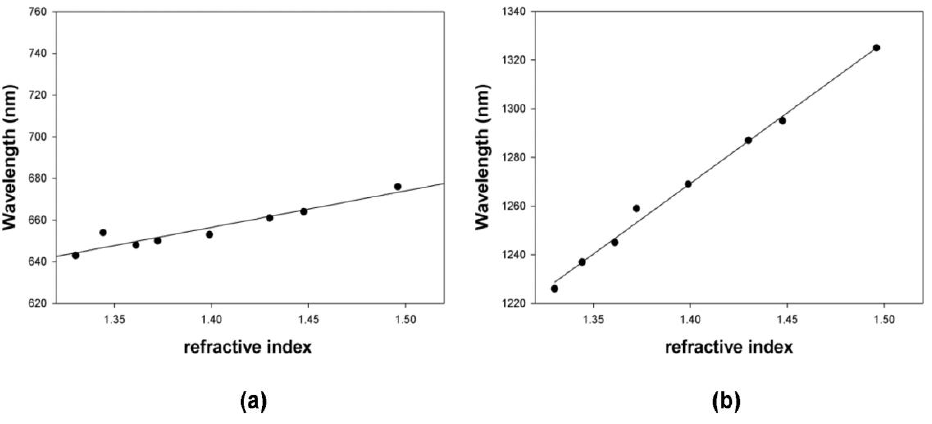
Figure 8. Plasmon resonance wavelength as a function of the refractive index (a: LSPR 2, b: LSPR 3), when the gold nanostars are suspended in different solvents: water (n = 1.3300); acetonitrile (n = 1.3442); ethanol (n = 1.3611); ethyl acetate (n = 1.3723); n -butanol (n = 1.3990); N,N-dimethylformamide (n = 1.4300); chloroform (n =